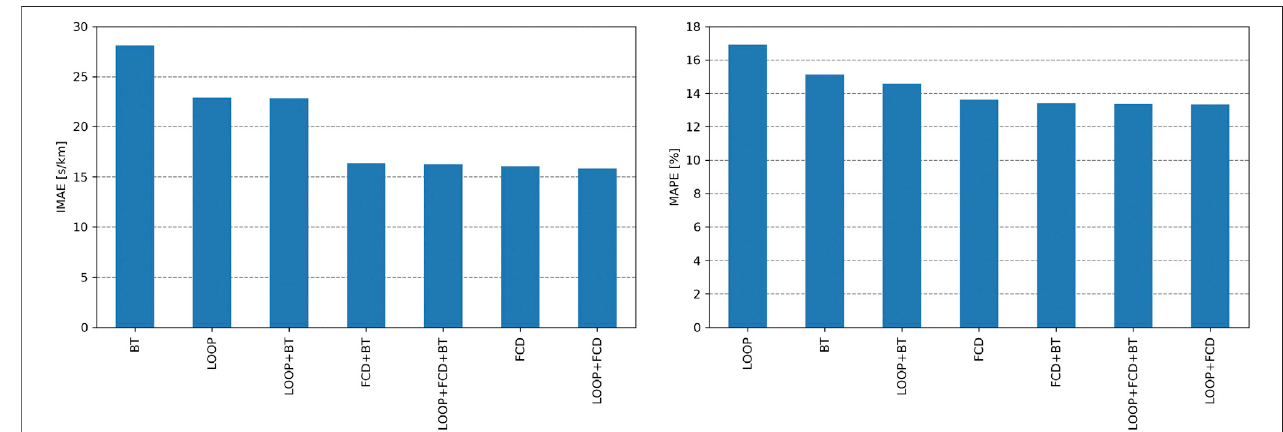
FIGURE 9 | Lowest IMAE and MAPE using the most accurate reconstruction algorithm with respect to the available data source.